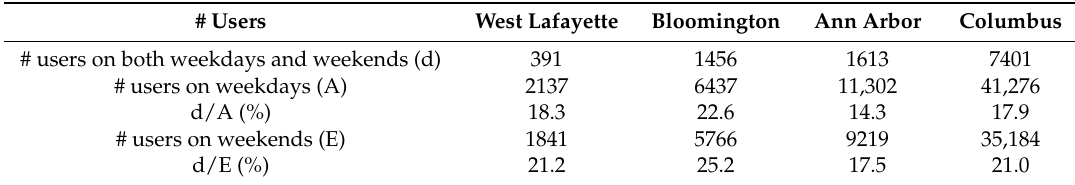
Table 3. Number of distinct users on weekdays and weekends.